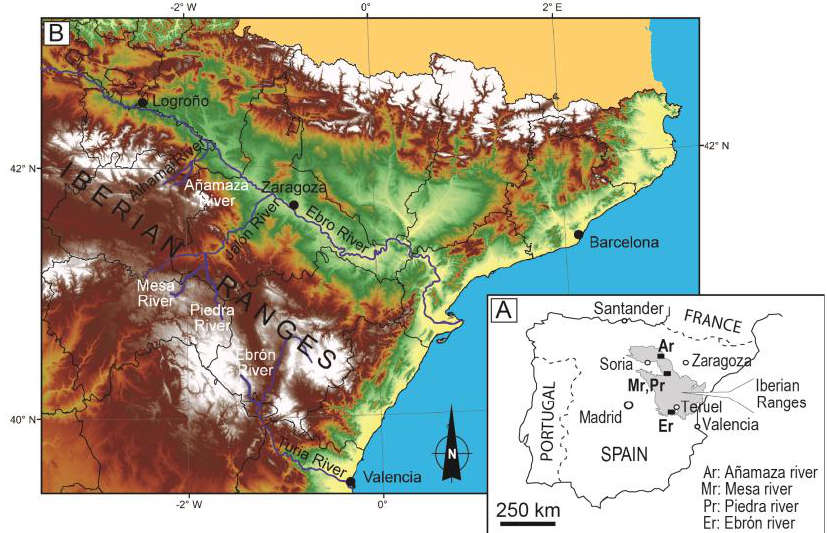
Figure 1. ( A,B ) Locations of the studied rivers in Iberian Ranges (NE Iberian Peninsula). Figure 1. ( A , B ) Locations of the studied rivers in Iberian Ranges (NE Iberian